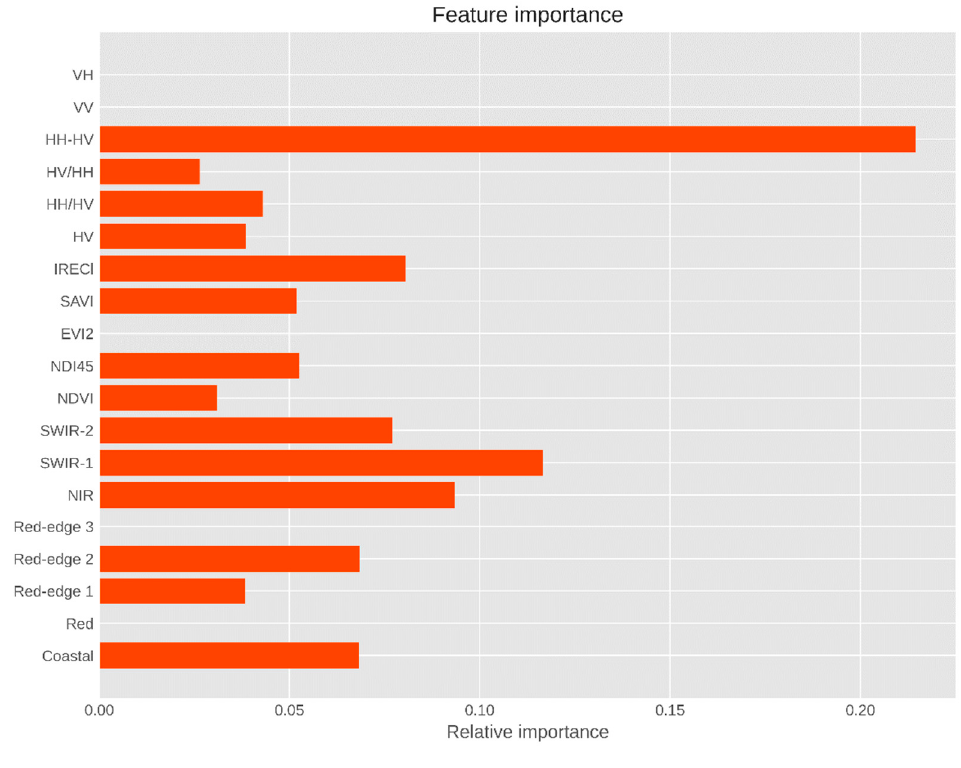
Figure 5. Variable importance of the S-2, S-1, and ALOS-2 PALSAR-2 data in the present study.